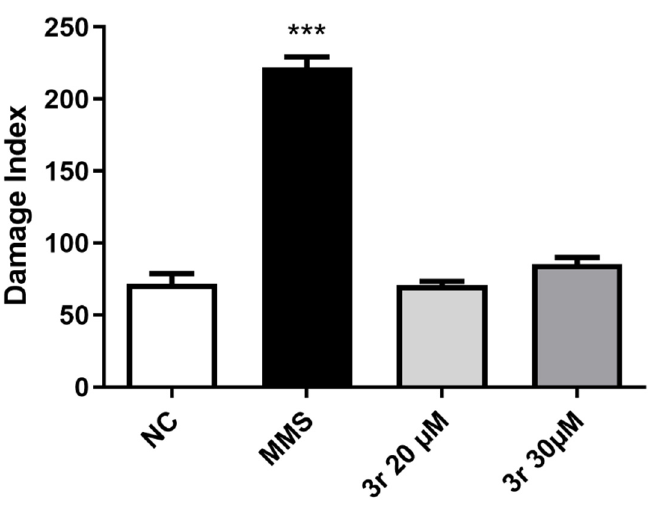
Figure 1. DNA damage index measured by alkaline comet assay in HepG2 cells incubated for 24 h with 3r . NC = control vehicle group (0.5% DMSO), MMS = methyl methanesulfonate, positive control group. Data are expressed as the mean ± standard error from two independent experiments. Statistical analysis was performed by one-way analysis of variance followed by Dunnett’s post-test. *** p <